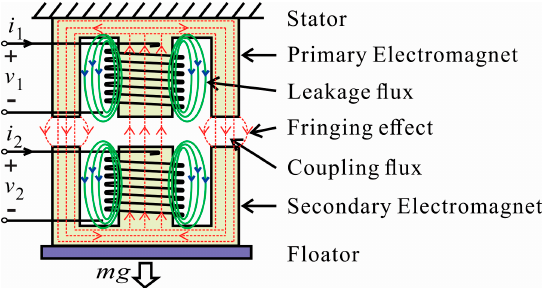
Figure 2. Schematic diagram of the basic model showing the flow of flux through the core and air gap.